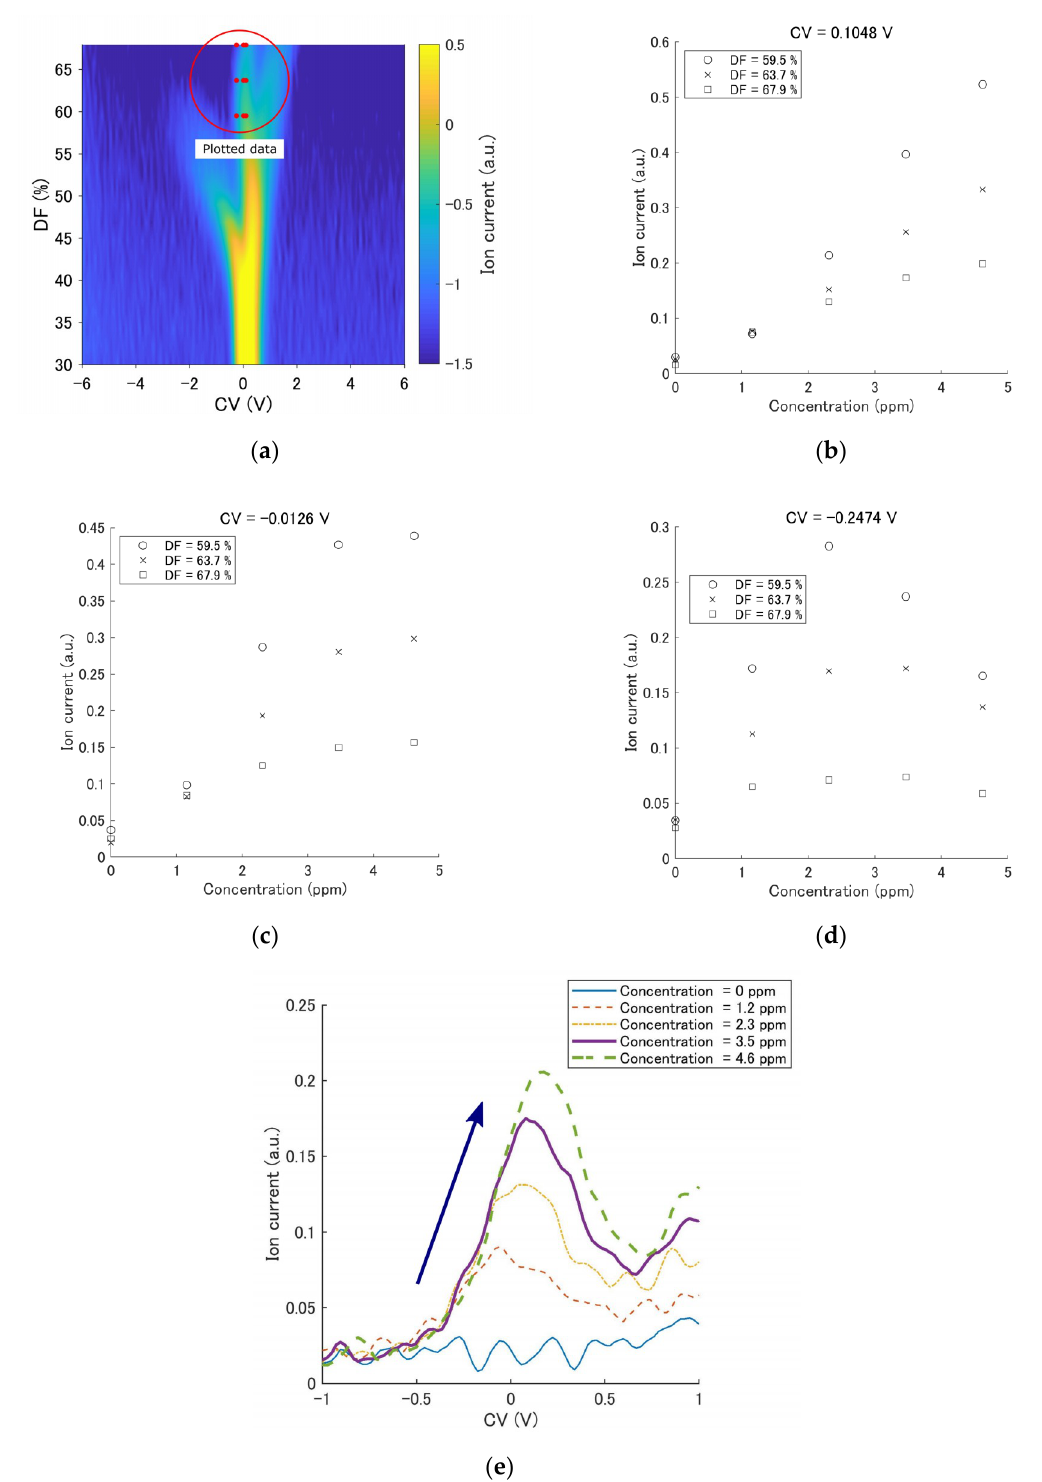
Figure 3. An example of a single component measurement: response to acetone as a function of concentration. Dispersion fields (DFs) of 59.5, 63.7, and 67.9% were selected. ( a ) The measurement result of 4.6 ppm acetone was obtained. The red circle indicates the portion of plotted data in the graphs. ( b ) The output at compensation voltage (CV) = 0.1048 V. ( c ) The output at CV = − 0.0126 V. ( d ) The output at CV = − 0.2474 V. ( e ) The output at DF = 67.9%, CV = − 1 to 1 V.